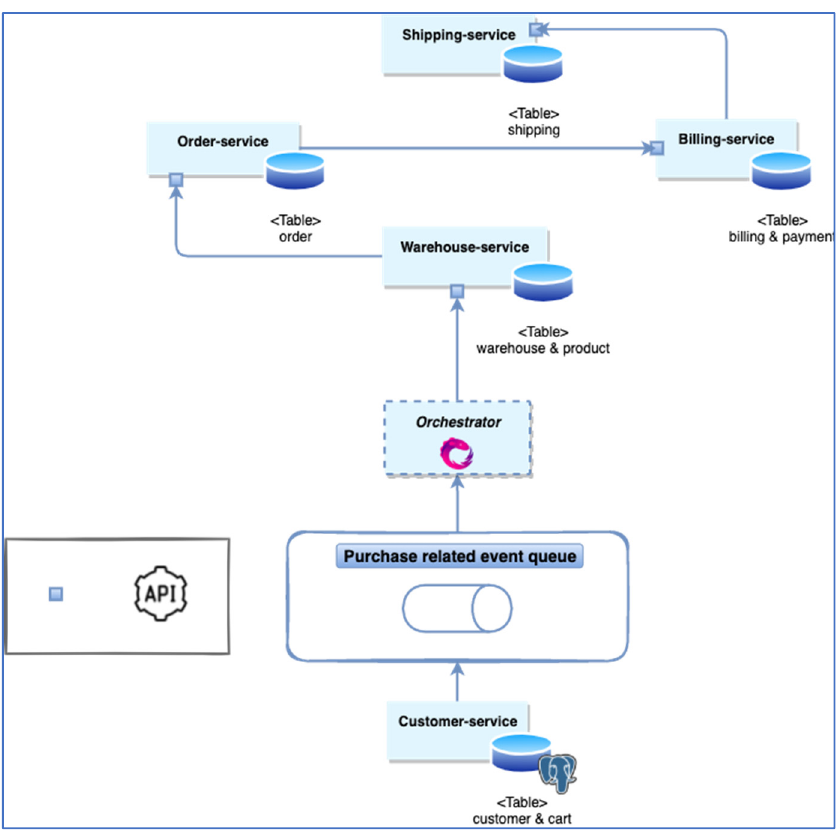
Figure 6. The architecture of a system with the standard baseline standard sage pattern.